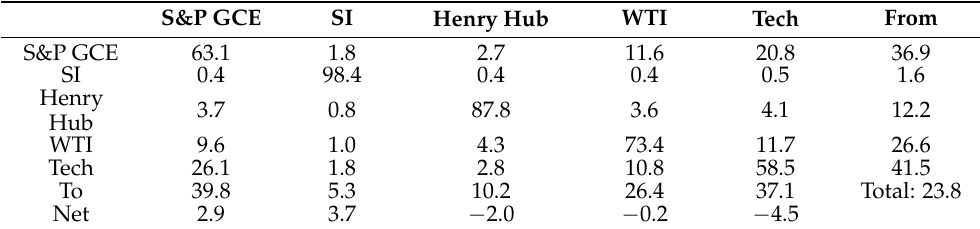
Table 3. Average dynamic volatility